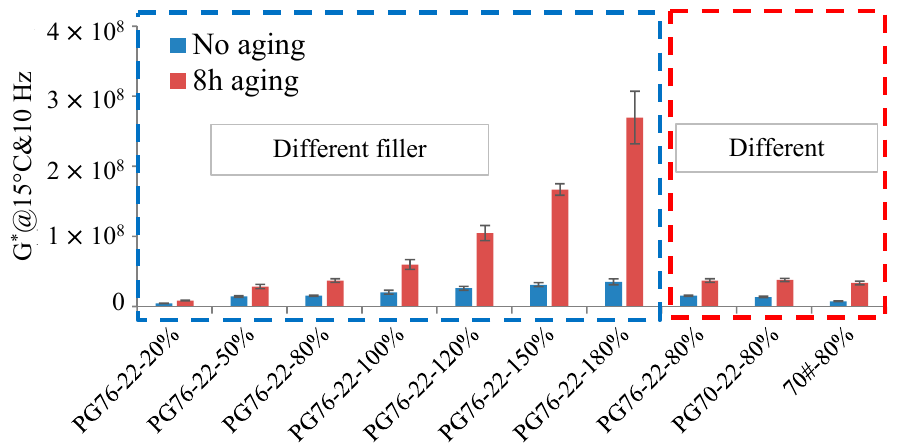
Figure 7. Fatigue parameters (G*sin δ @ 15 °C and 10 Hz) of different mastics with varying filler contents and binders before and after aging.